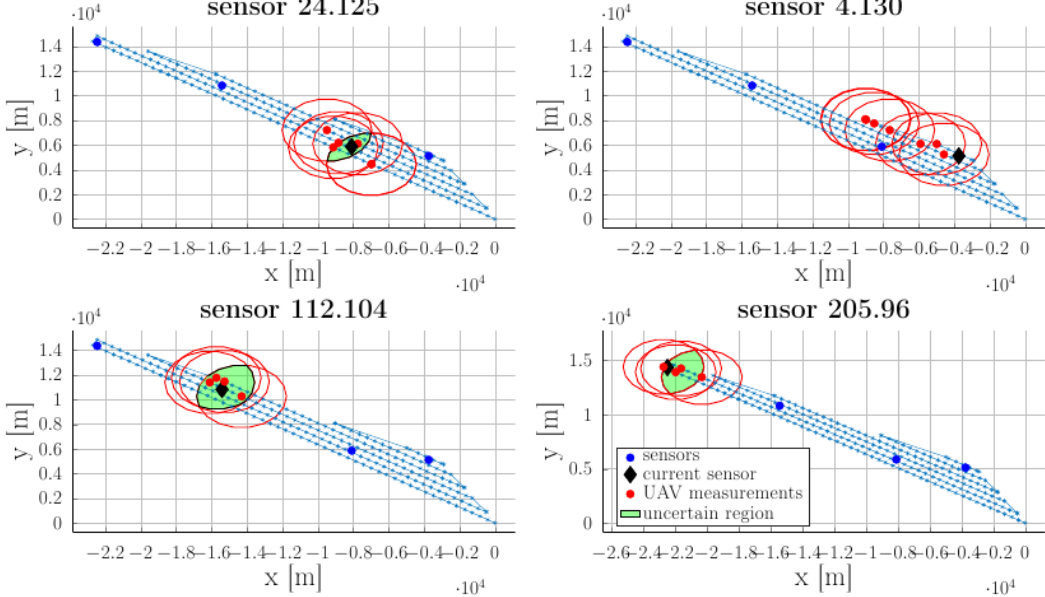
Figure 15. Sensors’ estimated location as the result of succesive UAV mesurements.